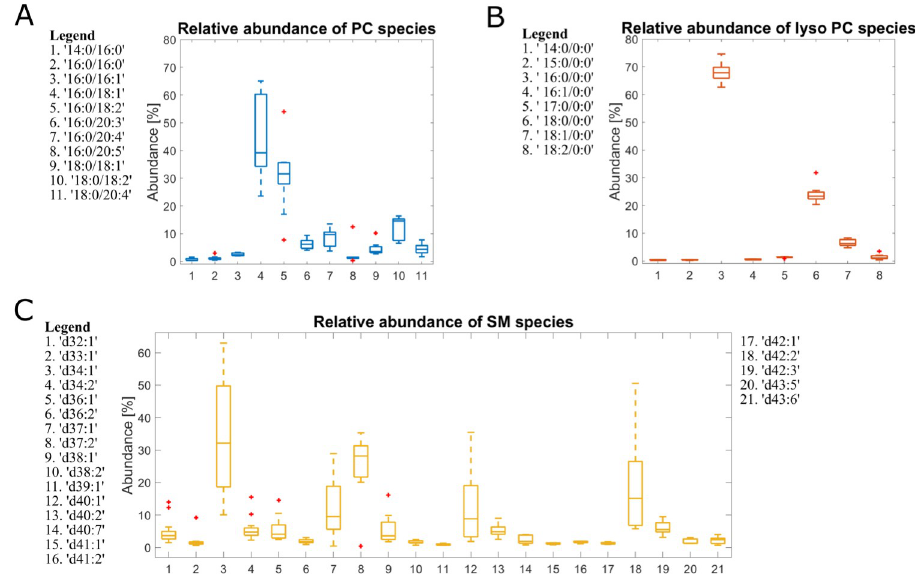
Fig 4. MS analysis of lipid species abundance for PC, SM, PI and PE. Lipids identified by MS2 has been quantified by MS1 chromatogram reconstruction. The bar plots represent the relative abundance of each lipid species towards other lipid species with the same headgroup. Centr3l mark indicates median, the bottom and top edges of the box indicates 25th and 75th percentiles, respectively. The whisker extends to the most extreme data points not considered outliers and the outliers are plotted as ‘+’